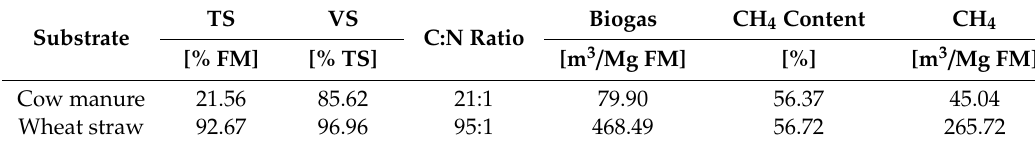
Table 2. The basic parameters and biogas yield of the tested